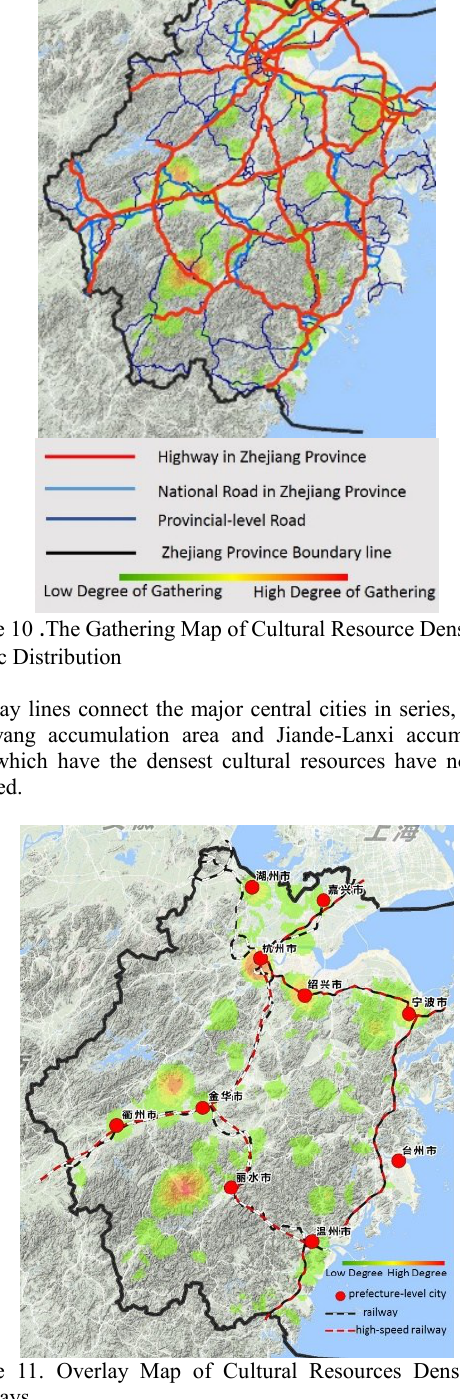
Figure 8. Culture Resources Density and Tourism Development